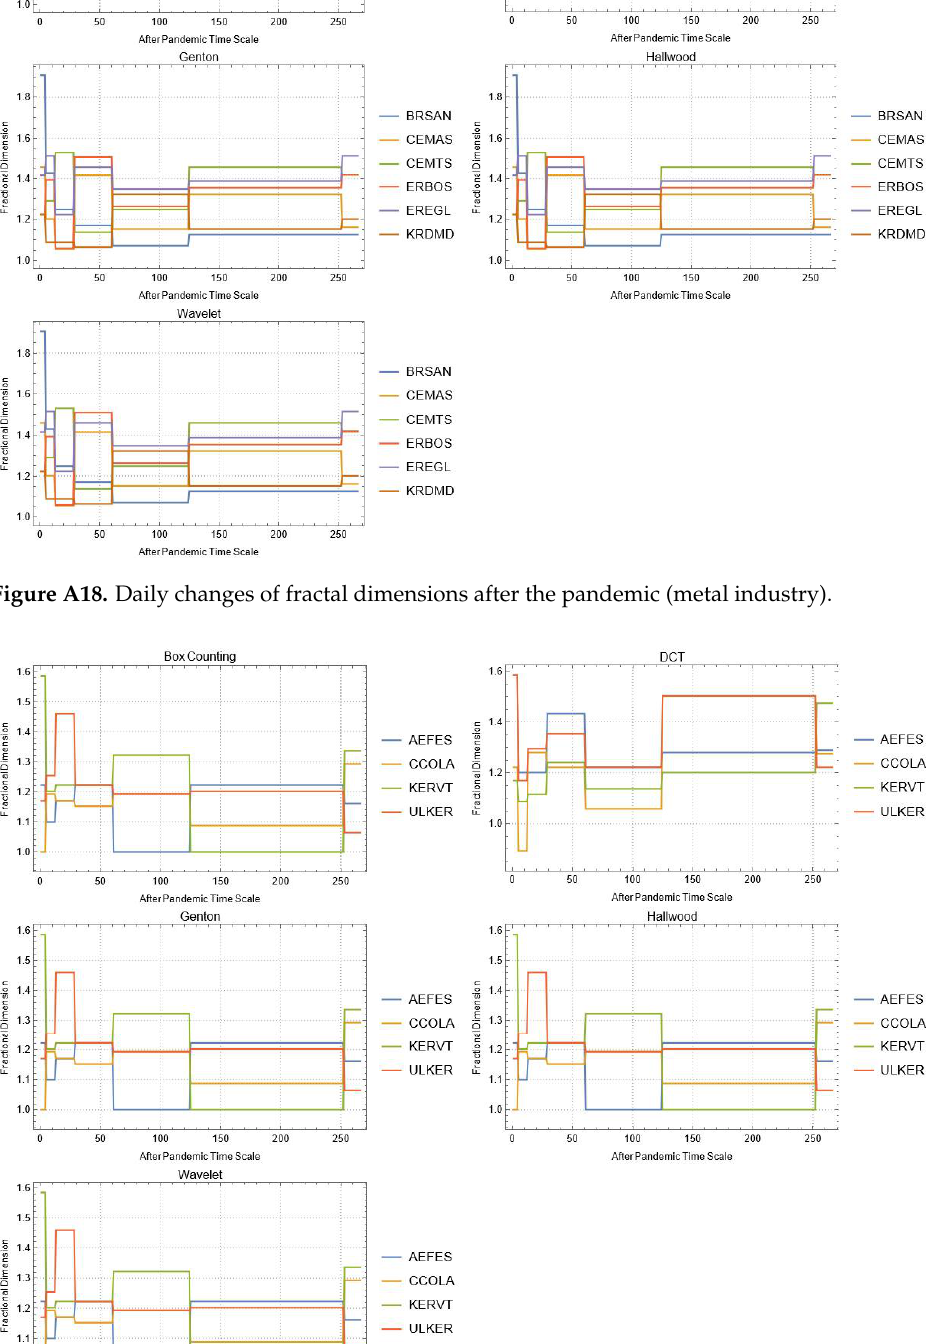
Figure A19. Daily changes of fractal dimensions after the pandemic (food, beverage and tobacco).